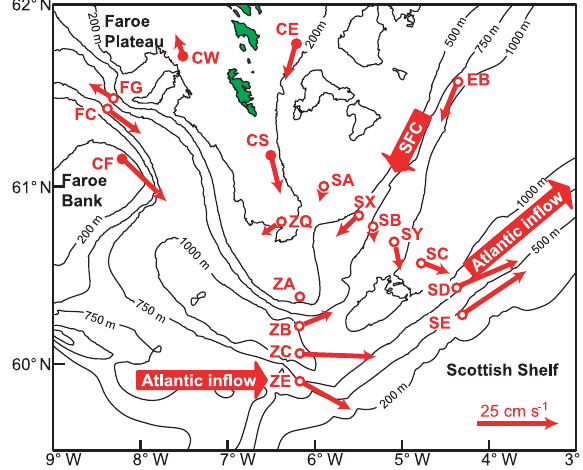
Figure 3. Atlantic water circulation observed by single-point (filled circles) and profiling (open circles) current meters. Red arrows in- dicate average velocity vectors at 40m depth for the single-point moorings (Table S1) and at selected (see Table S2) depths within the Atlantic layer for the ADCP sites. Velocity scale is indicated in the lower right corner. At site ZA, the velocity was too weak for an arrow to be visible in the chosen